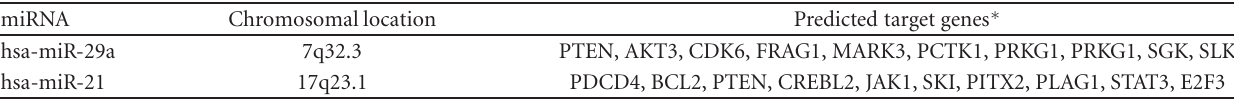
Figure 2: Scatter plot of serum levels of (a) miR-29a and (b) miR-21 in controls (C, n = 20) and breast cancer patients (BC, n = 20). Expression level of miRNAs was normalized to RUNB6. The line represents the mean value. Statistically significantdi ff erence wasdetermined by Mann-Whitney test with GraphPad Prism 5 Demo software. Table 2: Di ff erentially expressed miRNAs and predicted target genes.